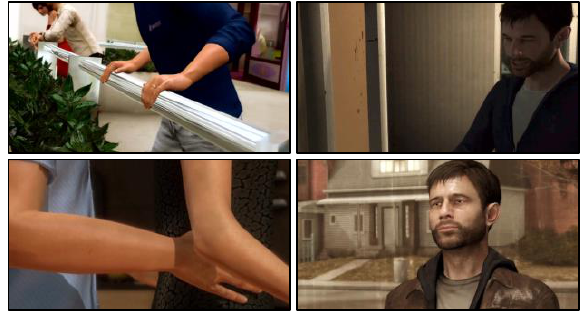
Figure 7 | We can see two extreme close ups of hands, and two close ups of face expressions, emphasizing the expressivity of each scene. Pictures from Heavy Rain